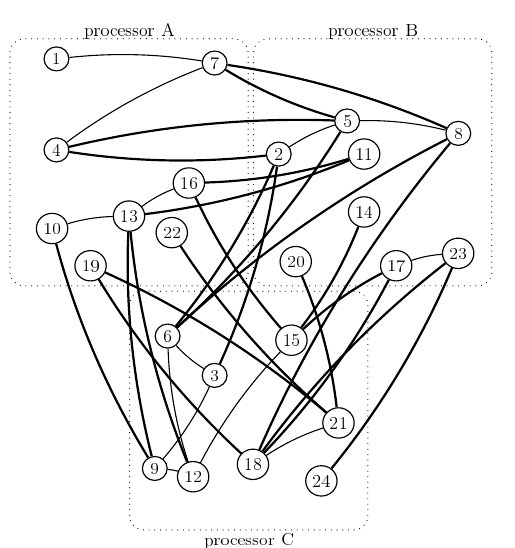
Figure 1. Random partitioning of a sample graph G(24,36) among three processors; each processor node has 8 vertices; 24 intra-cluster edges (highlighted in bold) and 12 inter- cluster